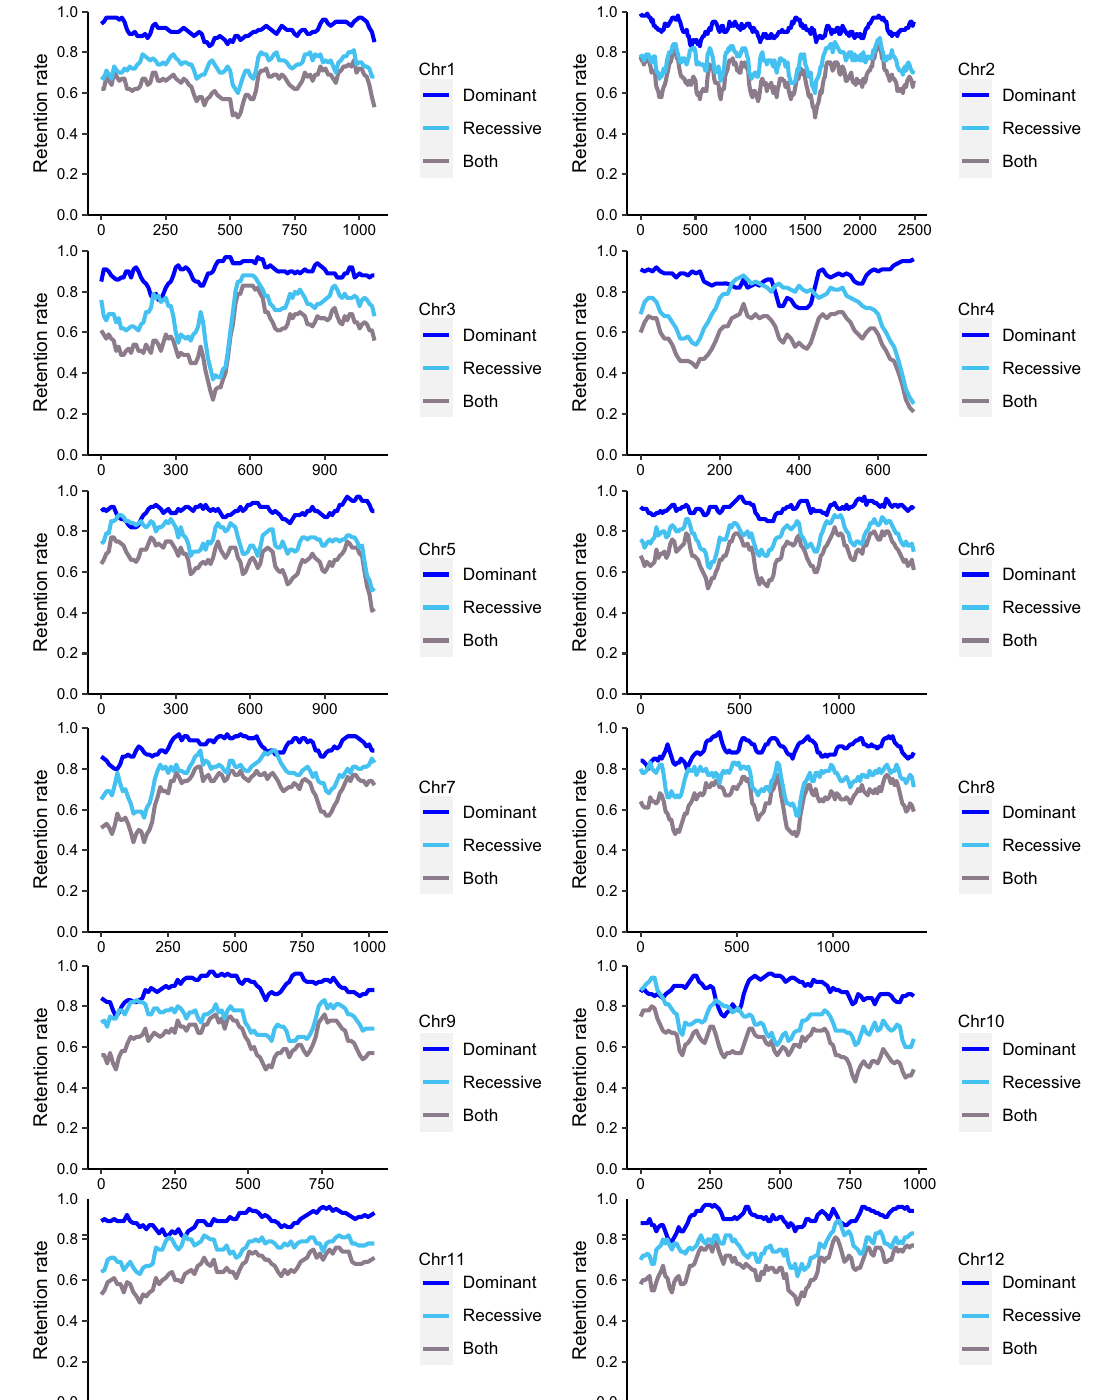
subgenomes (gray), corresponding to Q. lobata chromosomes. The percentage of retained orthologous genes in R. chiliantha was calculated based on 100-gene sliding windows along each Q. lobata chromosome. Source data are provided as a Source Data fi